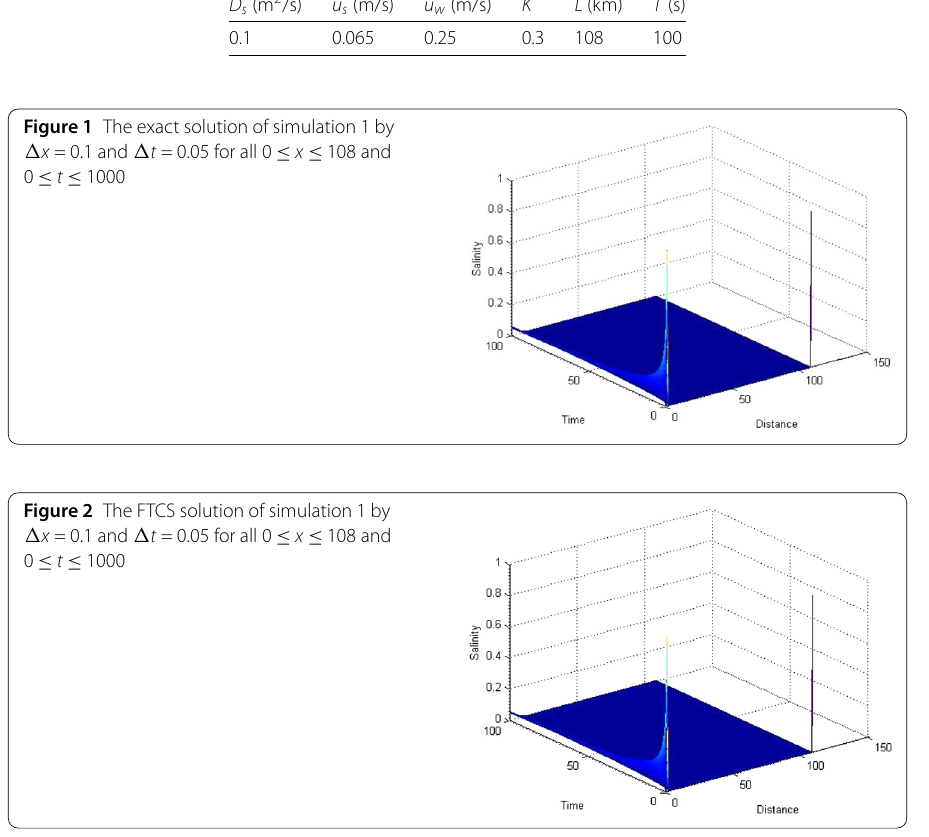
Table 3 The maximum absolute error defined by err max = max |˜ c ( x i , T ) – c ( x i , T ) | for all i = 0,1, ... , N , where T = 10,20,30, and 40 T FTCS Saulyev err